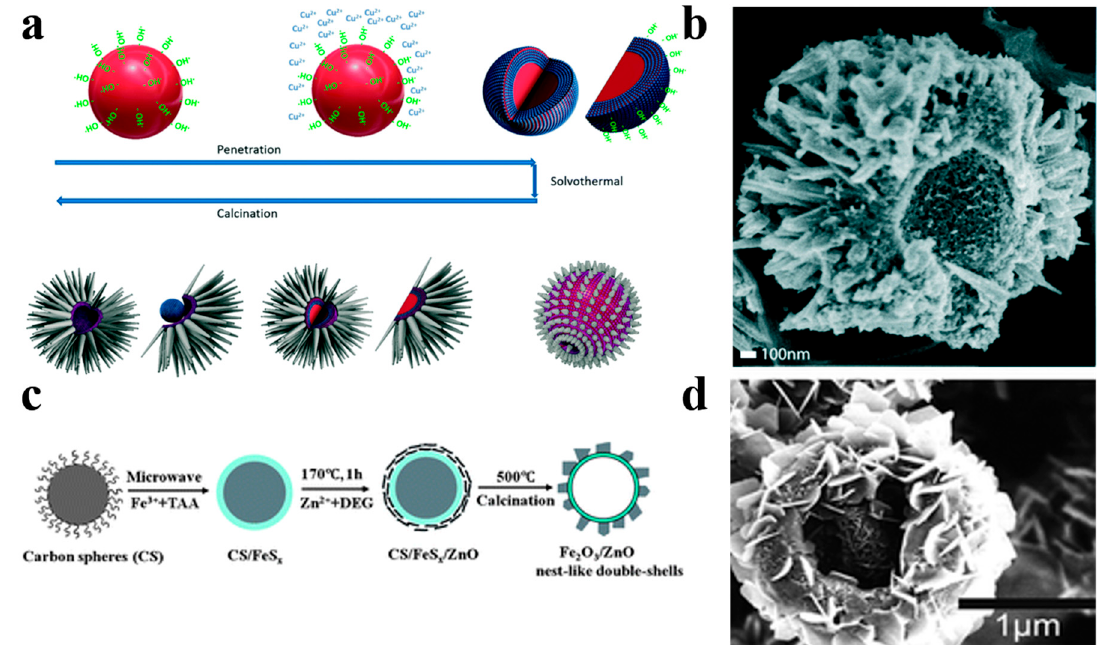
Figure 14. ( a ) Schematic diagram of the fabrication process of hollow hierarchical CuO/TiO 2 structure. ( b ) SEM image of the CuO/TiO 2 spheres. Reproduced with permission from [85]. Copyright 2017, RSC. ( c ) Schematic diagram of the preparation process of nest-like γ -Fe 2 O 3 /ZnO hollow nanostructures. ( d ) SEM images of g -Fe 2 O 3 /ZnO nest-like hollow nanostructures. Reproduced with permission from [88]. Copyright Royal Society of Chemistry, 2012.